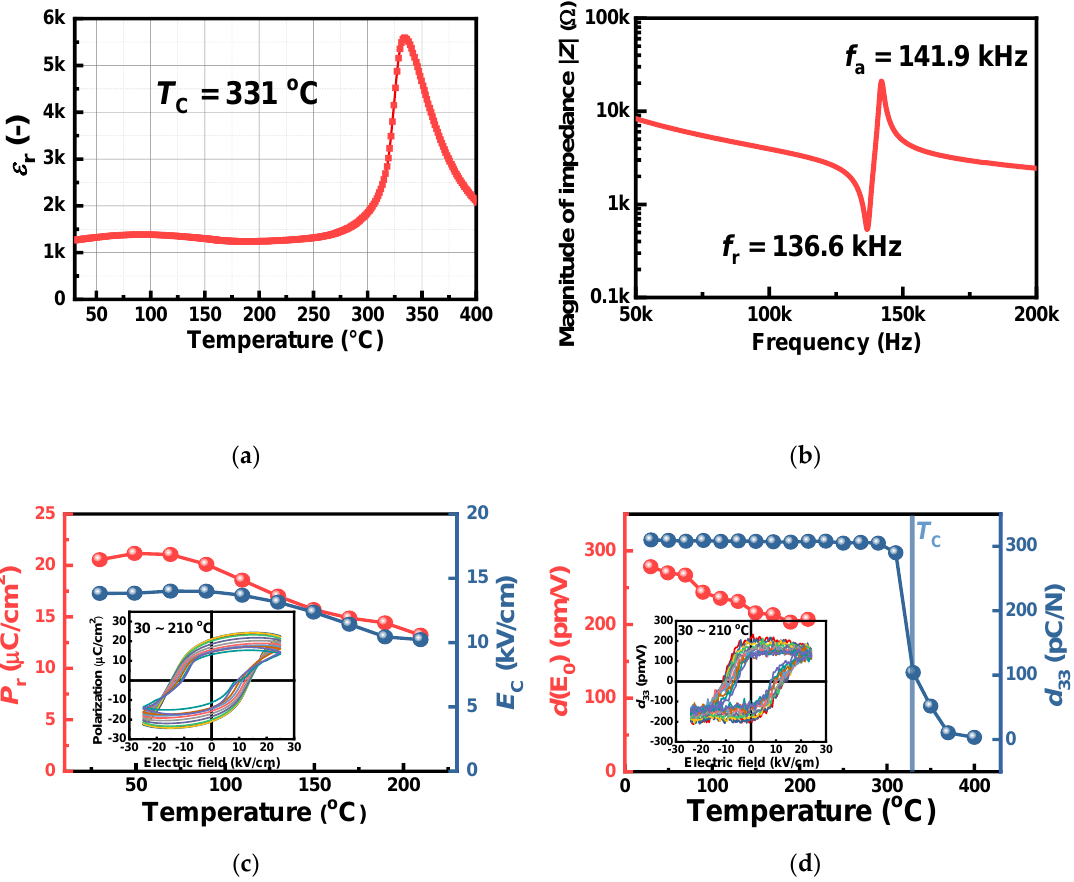
Figure 3. ( a ) Temperature-dependent dielectric constant r of the KNN-BNKLZ-BS ceramic ring. ( b ) Impedance – frequency profile showing resonant frequency f r and anti-resonant frequency f a . ( c ) Temperature-dependent P r and E C (inset shows temperature-dependent P - E loops between 30 and 210 °C). ( d ) In-situ temperature-dependent d (E 0 ) and thermal aging of static d 33 (inset shows temperature-dependent small-signal d 33 - E loops between 30 and 210 °C). Table 1. Material properties of KNN-BNKLZ-BS and PZT ceramic rings.